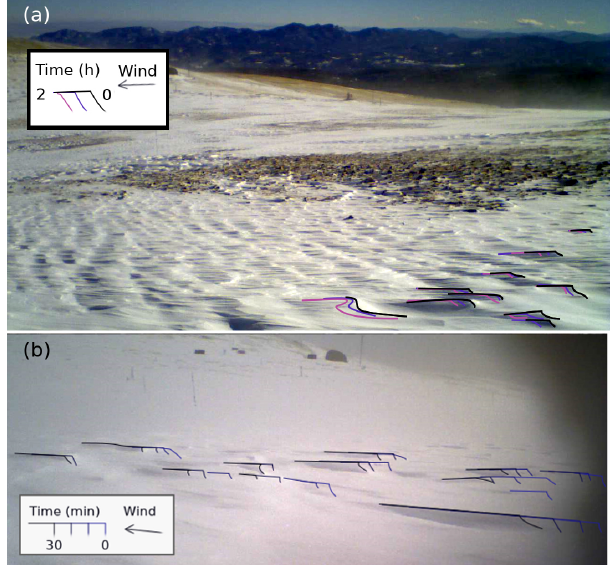
Figure 6. Time lapse of sastrugi crests (a) from 15:30 (pictured) to 17:30 on 18 November 2016 (video S1 at 2:51) and (b) from 10:23 to 10:53 (pictured) on 25 March 2016 (video S1 at 3:05).